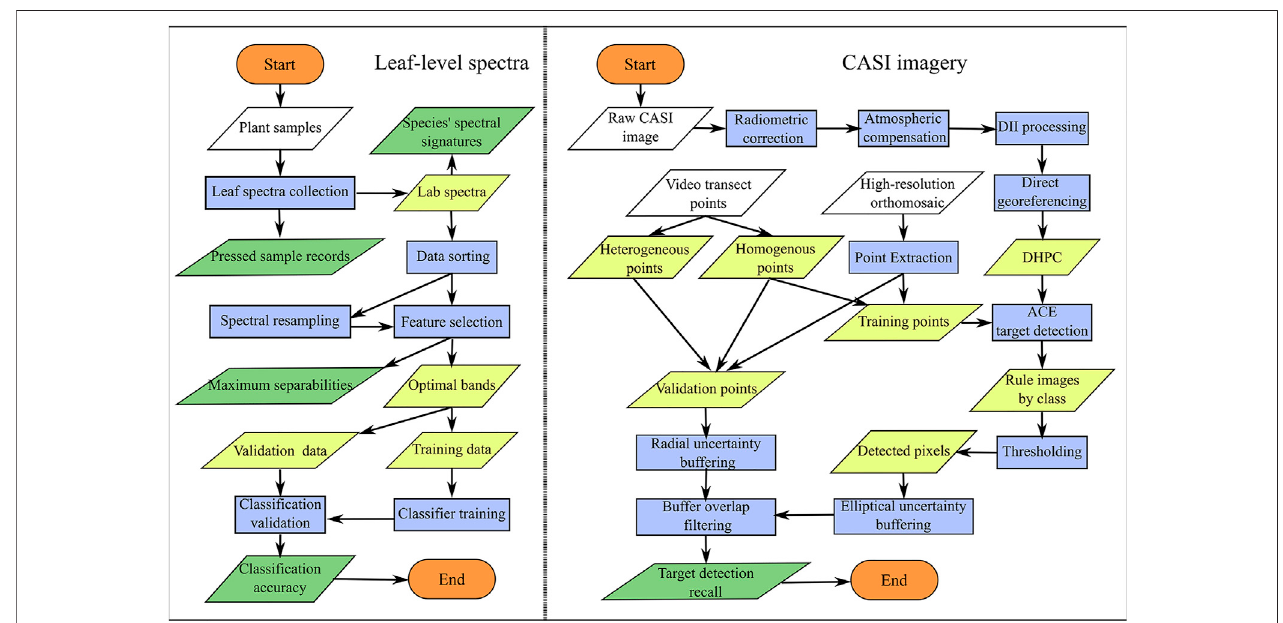
FIGURE 4 | Work fl ow for both the leaf level spectral analysis and the processing and analysis of the CASI image.